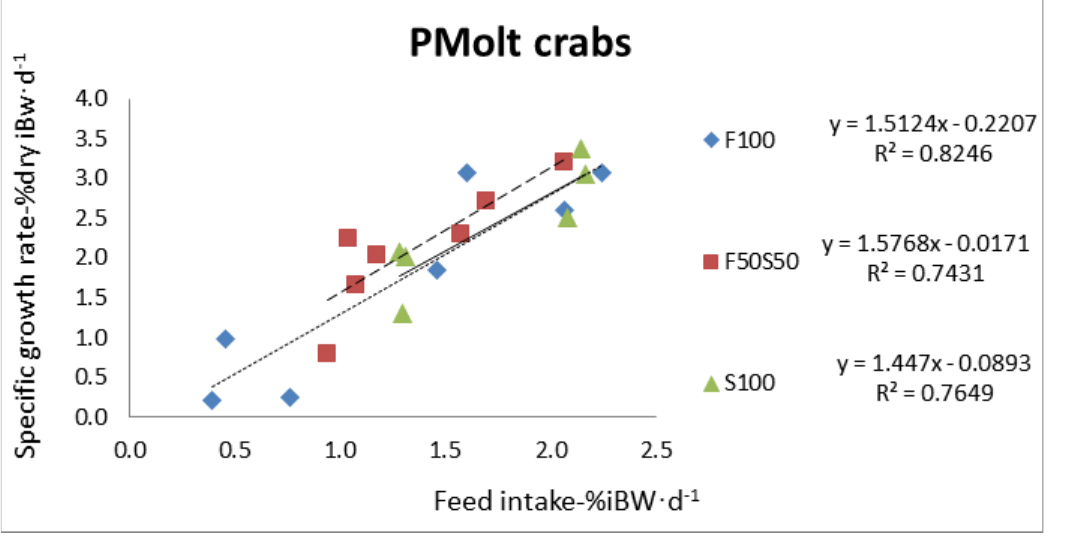
Figure 3. Relationship between specific growth rate (SGRd) and feed intake of juvenile crabs for the 3 experimental diets for PMolt crabs. Amount of feed intake is percentage of initial fresh body weight (iBW) per day.